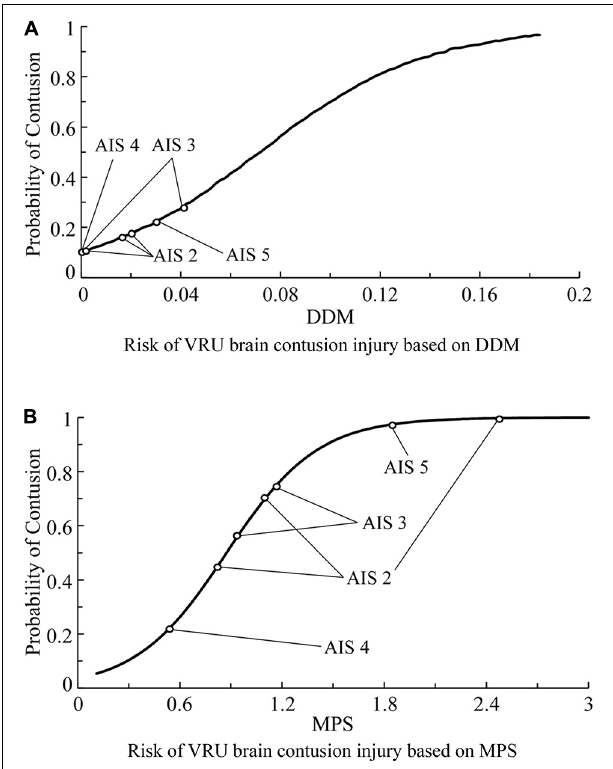
FIGURE 12 | Predicted probability of the brain contusion occurrence for the VRU impact accident cases analyzed in this study using brain injury risk curves reported in the literature (Takhounts et al., 2003, 2008). (A) Risk of VRU brain contusion injury based on DDM and (B) Risk of VRU brain contusion injury based on MPS. VRU, vulnerable road user; DDM, dilatation damage measure.